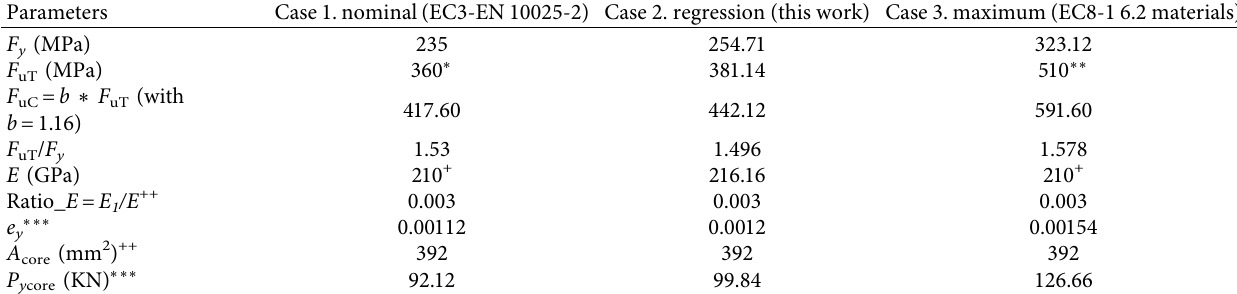
Figure 5: Progressive test: numerical model (a), applied displacement load of progressive test (b), and experimental and numerical load- deformation hysteretic curves (c). Table 3: Adopted steel core